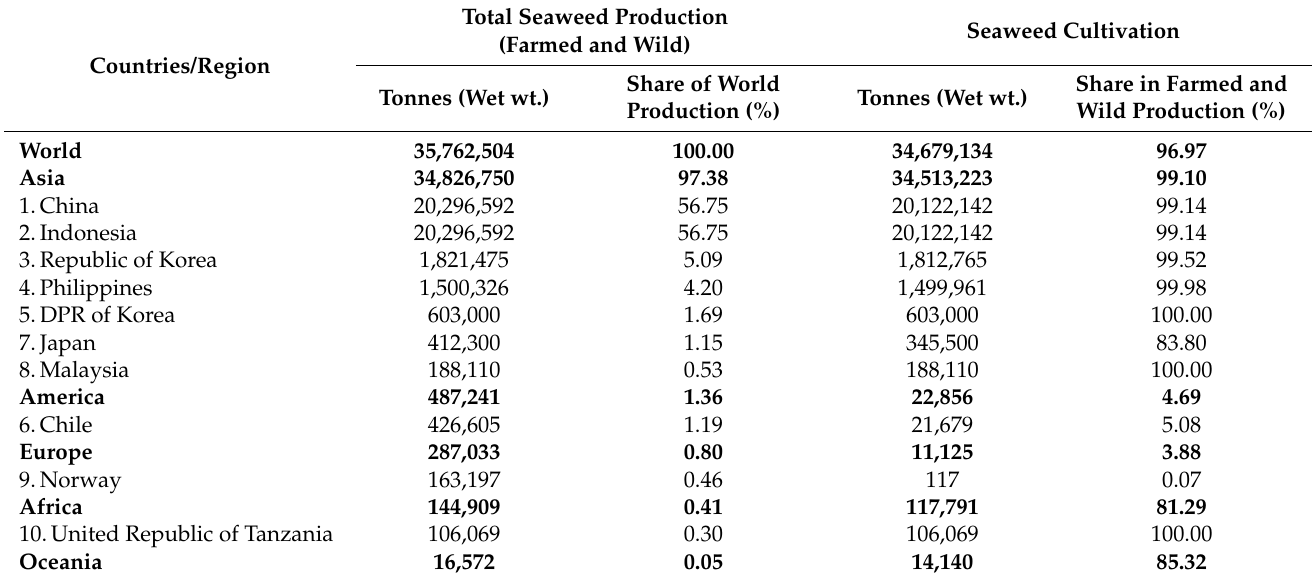
Table 1. Global seaweed production and comparison by region in 2019